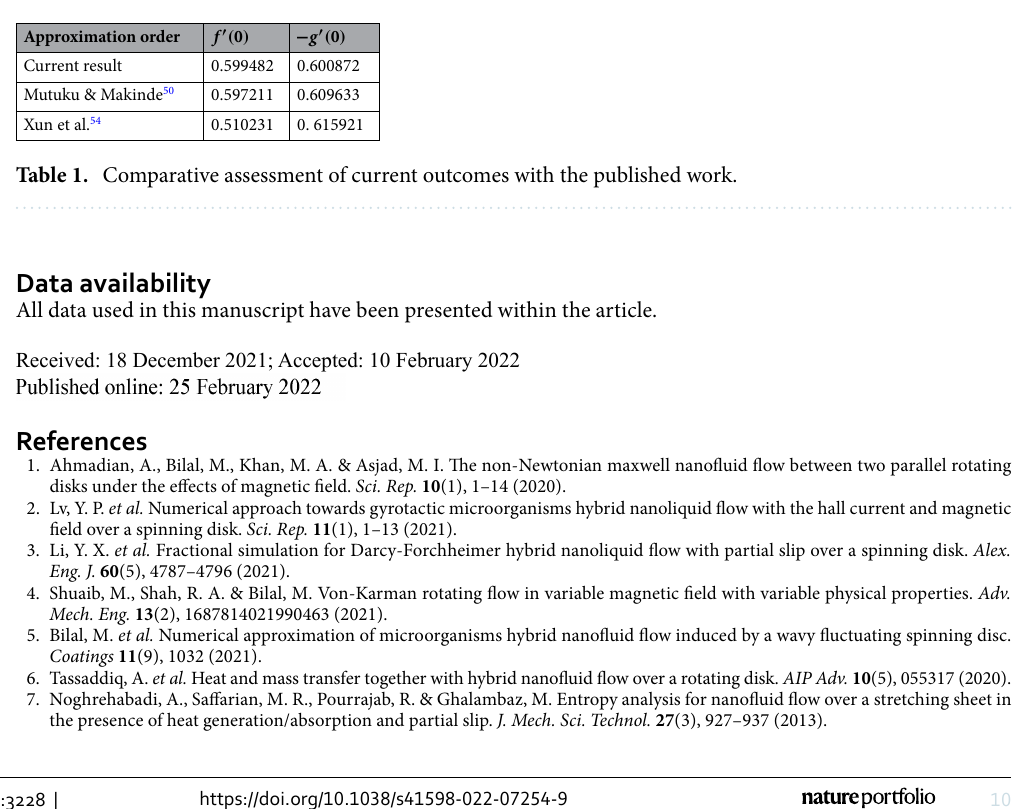
Figure 5. The nature of motile microbe χ(η) profile versus ( a ) suction/injection f w , ( b ) bio-convection Lewis number Lb , ( c ) microbe concentration variance (cid:31) , ( d ) bioconvection Peclet number Pe respectively.